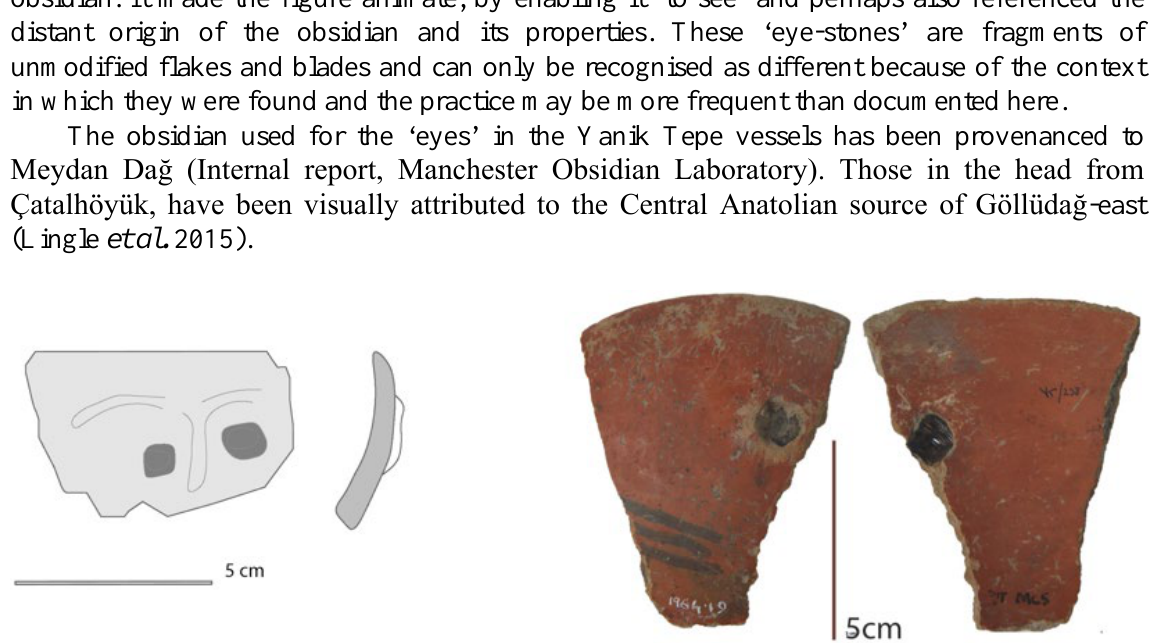
Figure 6. No. 1 Sherd of ceramic vessel from Yanik Tepe with obsidian inserts (re-drawn from Burney 1962: Pl. XLIII, 12); No. 2 Ceramic sherd with obsidian insert. Photograph by the